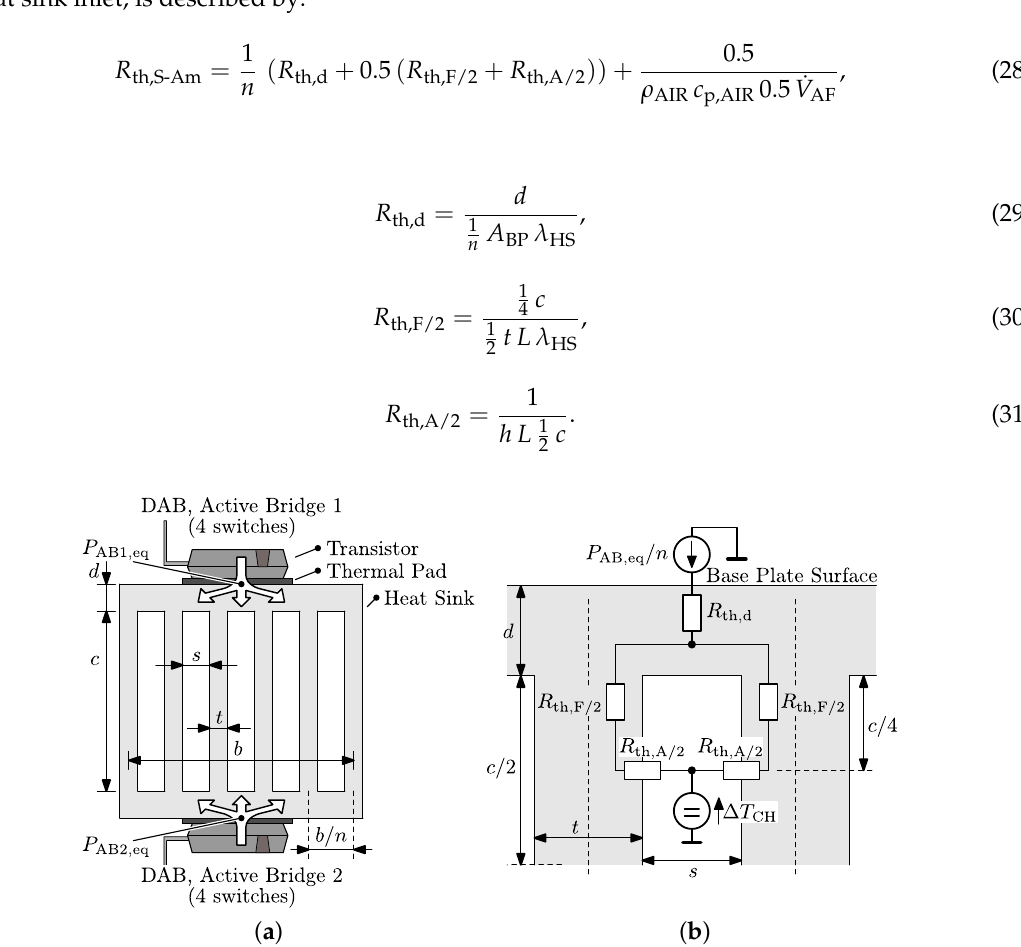
Figure 10. ( a ) Heat sink geometry with dual-sided base plate, considered to cool the switches of the DAB’s active bridges; ( b ) Thermal network describing stationary heat transfer between the surface of a base plate and the air in the heat sink channel (temperature T CH